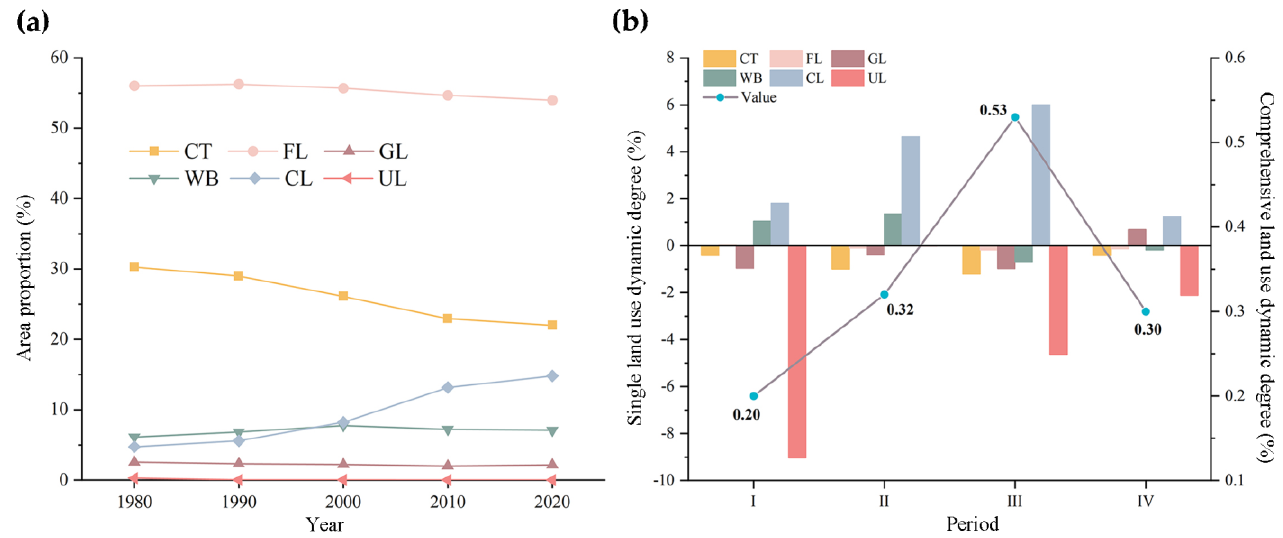
Figure 6. Area proportion of different land use types in the GBA ( a ), land use dynamic degree by cover type in each period ( b ). CT: cultivated land; FL: forestland; GL: grassland; WB: water bodies; CL: construction land; UL: unused land. Table 5. Land use transfer matrix by